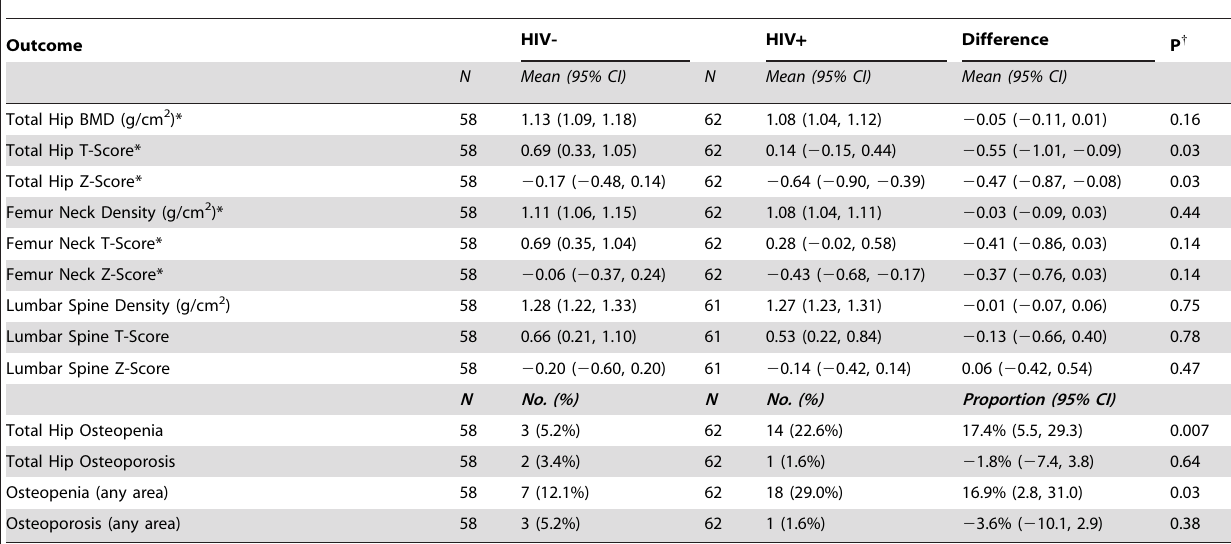
Table 2. BMD and bone turnover